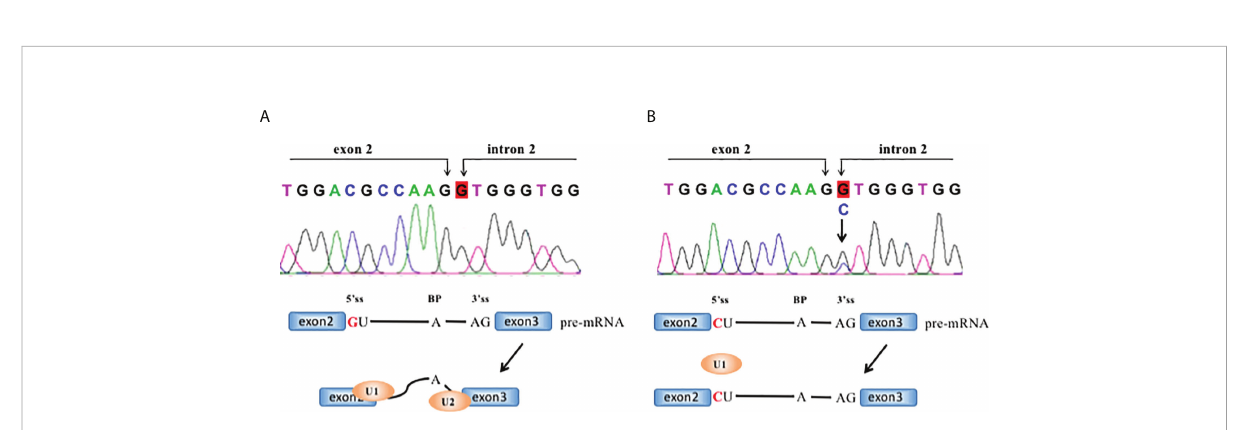
FIGURE 3 The ERCC2 intron2 c.105+1 G>C mutation and its effect in RNA splicing. RNA splicing of wild-type (A, B) mutant ERCC2 . Each intron has guanine and uracil (GU) at the 5 ′ -end and adenine and guanine (AG) at the 3 ′ -end. 5 ′ ss: 5 ′ splice site; 3 ′ ss: 3 ′ splice site; BP, branch